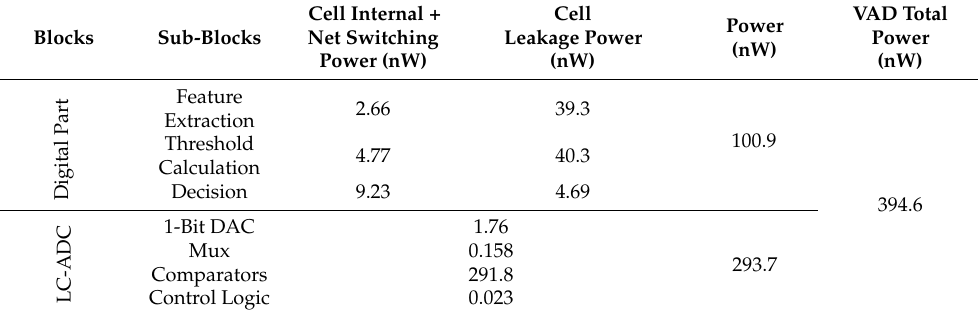
Table 2. Power consumption of different sub-blocks of proposed VAD system and total VAD power used for audio signal corrupted with 10 dB white